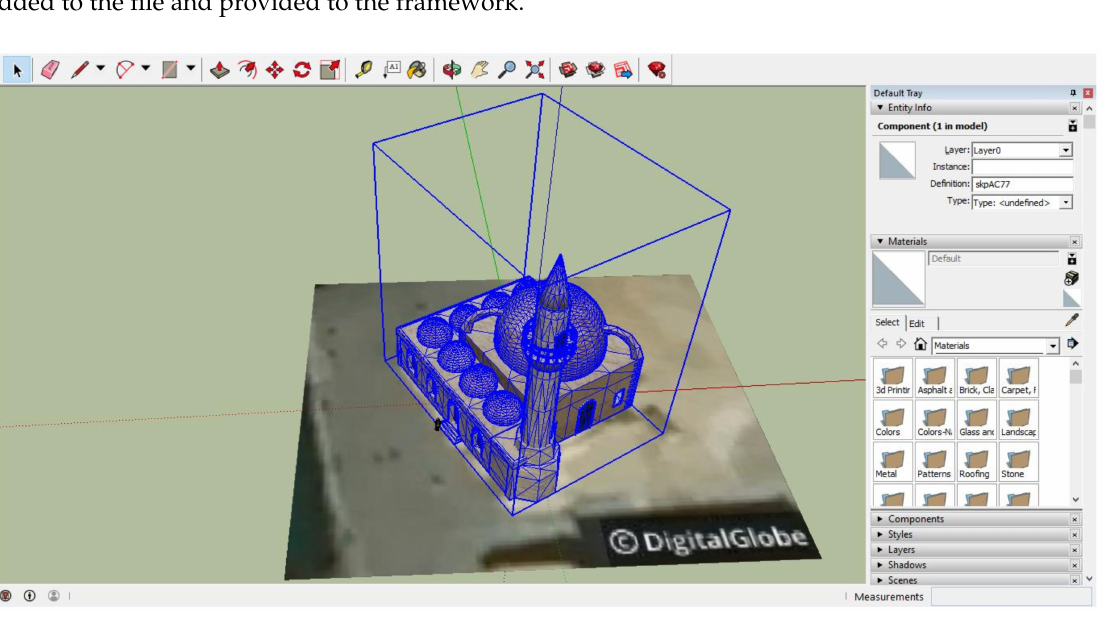
Figure 8. Geo-locating the model in Google